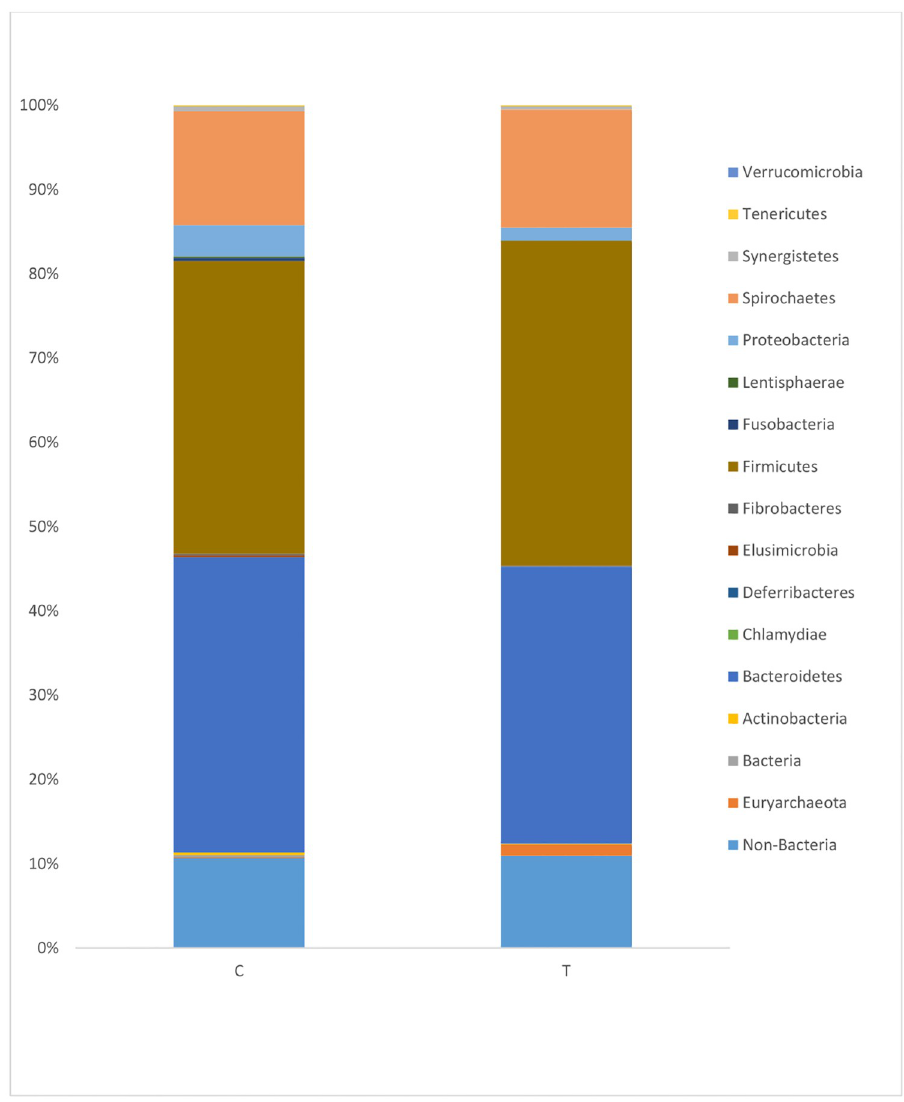
Fig 4. Bacterial taxonomic composition of phylum